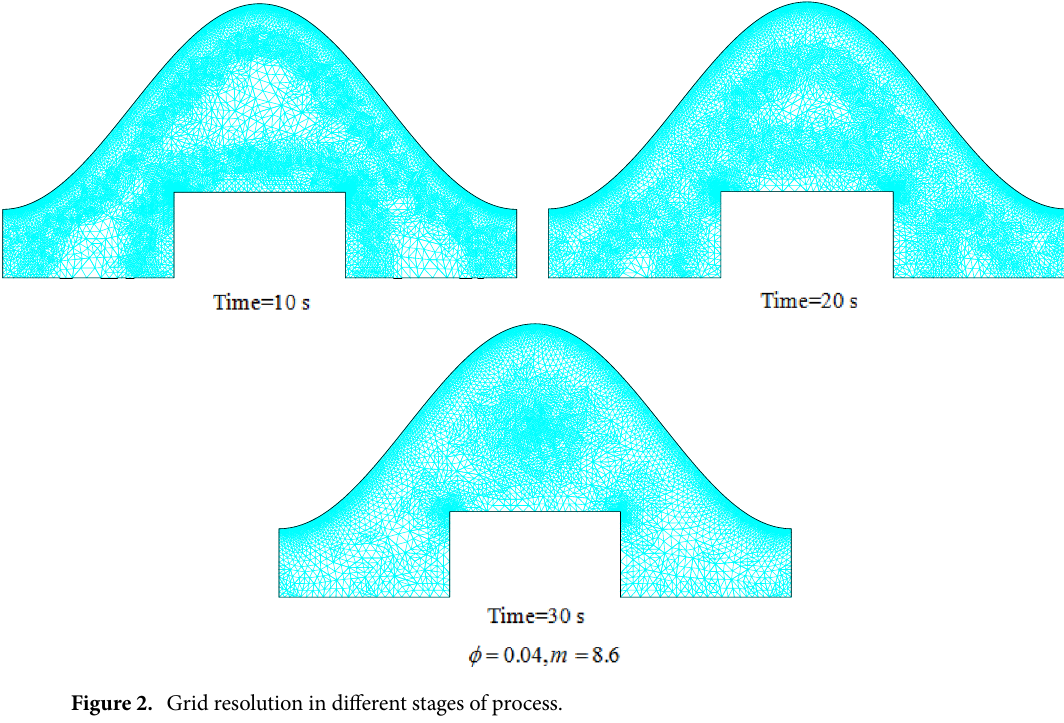
Figure 2. Grid resolution in different stages of process.